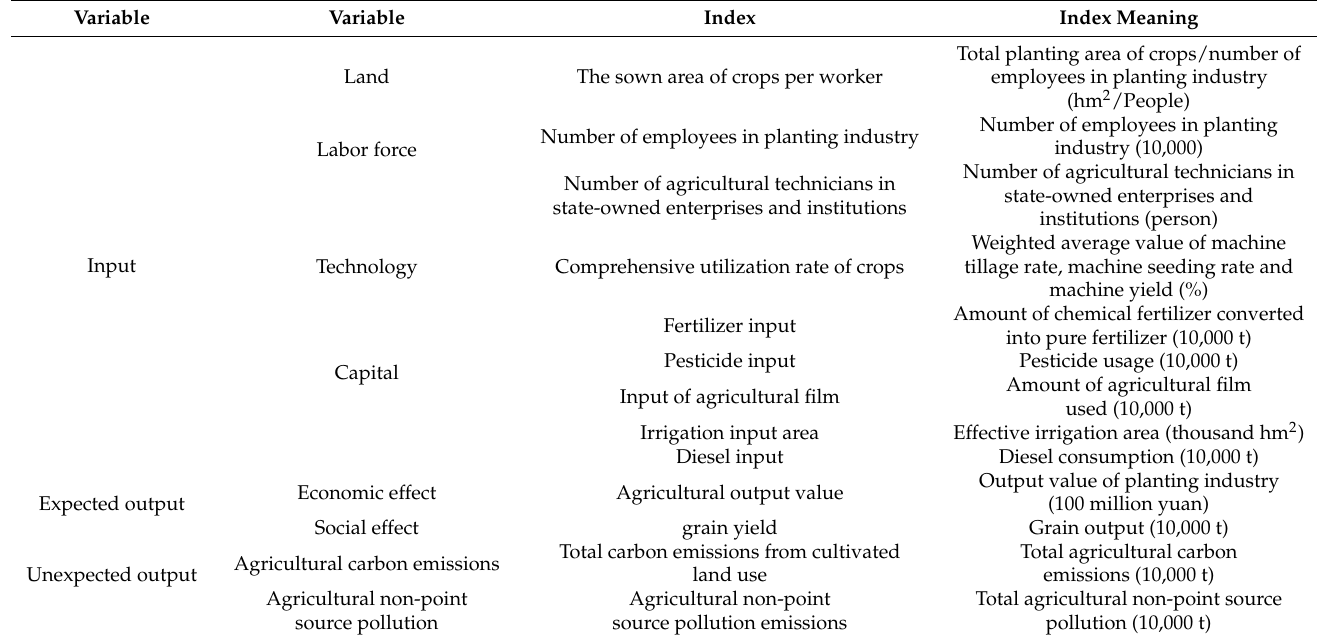
Table 1. Evaluation index system of green transformation efficiency of cultivated land